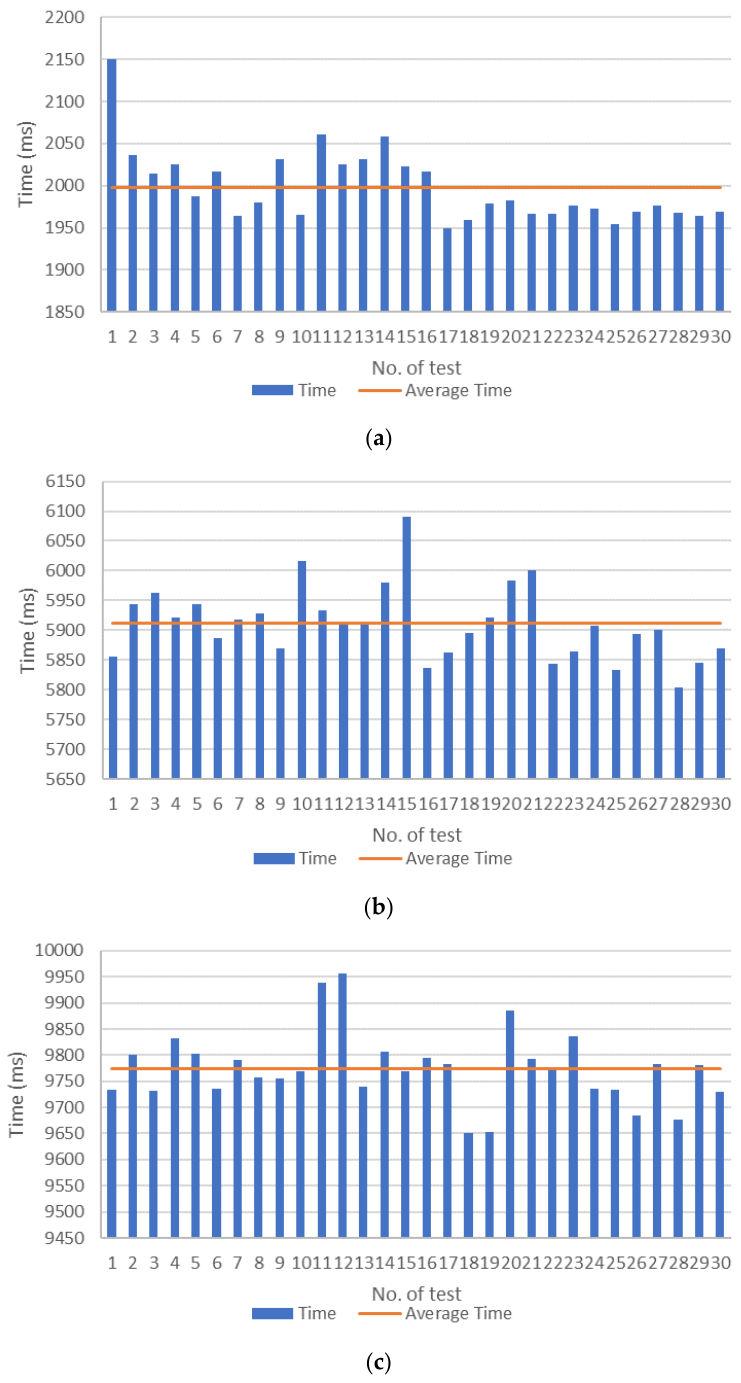
Figure 10. Test results of invoke operations. ( a ) 10 invokes (max: 2150; min: 1950; mean: 1998.1); ( b ) 30 invokes (max: 6090; min: 5804; mean: 5911.1); ( c ) 50 invokes (max: 9957; min: 9650; mean: 9773.5).